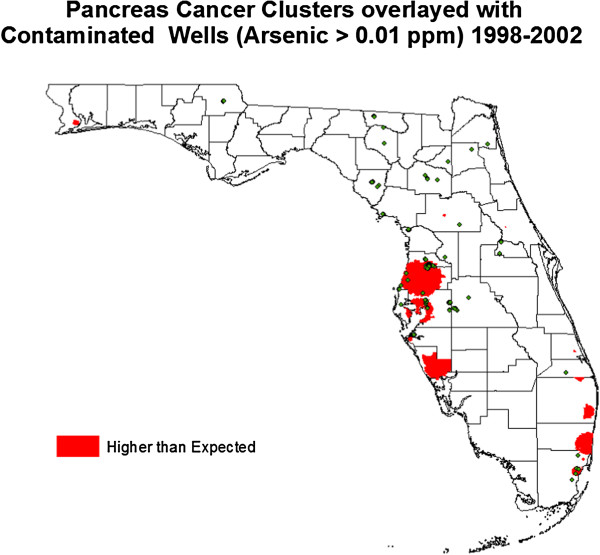
Pancreas Cancer Clusters overlaid with Arsenic Contaminated Wells in Florida 1998–2002: green circles represent arsenic contaminated wells and red areas represent higher than expected pancreatic cancer clusters.